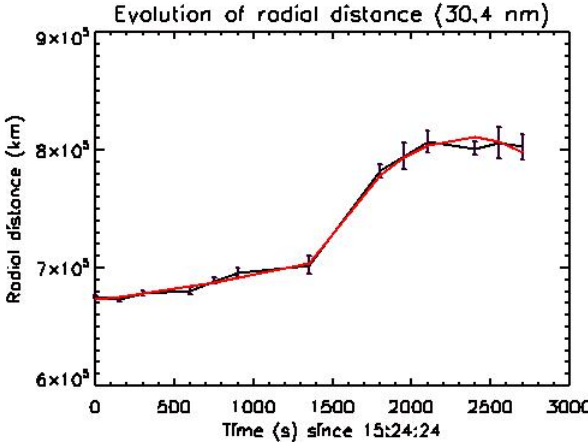
Fig. 4. Time profile of the jet’s leading edge radial distance on 11 November 2007 seen by STEREO A. The black line represents the positions at each temporal time with its corresponding error bars. The red line is the fit to the data